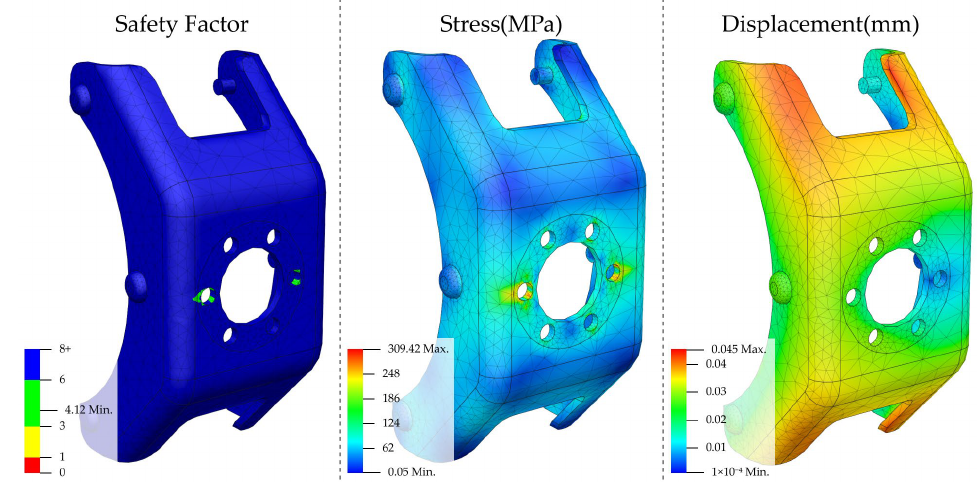
Figure 8. Analysis of condition 1 for hip connector 1. From left to right are the safety factor, stress, and displacement.